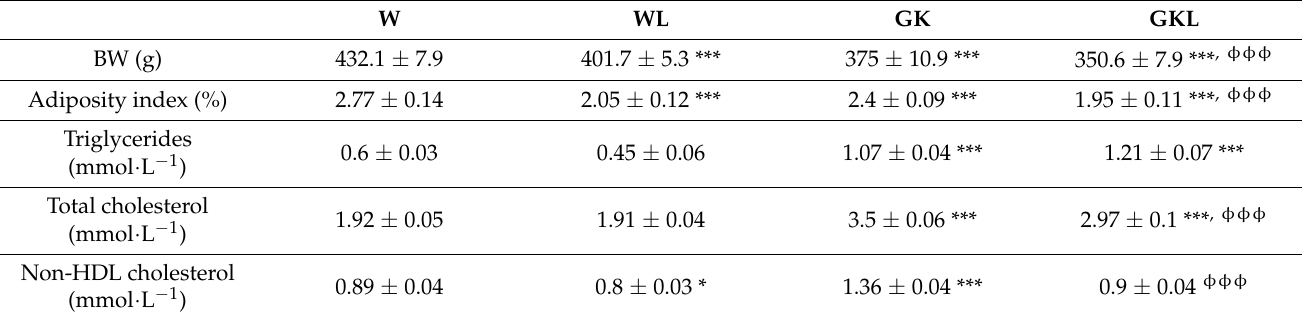
Table 1. Body weight, adiposity index, triglycerides, and cholesterol (total and non-HDL) levels in nondiabetic Wistar (W) and diabetic Goto-Kakizaki (GK) rats with (WL, GKL) or without luteolin treatment (W, GK).